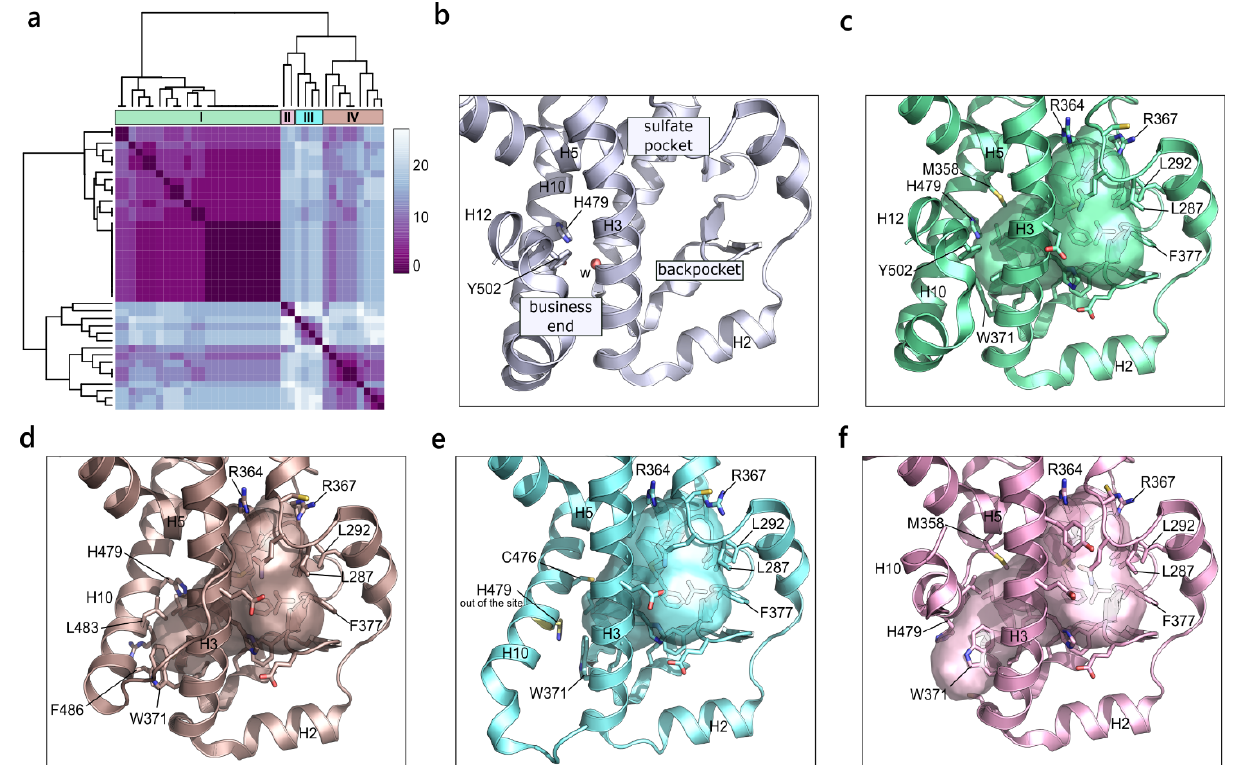
Figure 7. ( a ). ROR γ variability. Heatmap of the hierarchical clustering of ROR γ (PDB ID 5NI5). ( b ) Illustration of the ROR γ binding site. The main areas of the cavity are labelled. ( c ) Representation of the pocket described by cluster I as a result of the binding of agonist molecules or inverse agonist acting via the “water trap” mechanism (PDB ID 3KYT). ( d ) Pocket resulted from cluster IV and induced by inverse agonist acting via the “push and pull” mechanism (PDB ID 4WQP). ( e ) Representation of the pocket of cluster III. H479, pushed out of the binding site, is highlighted in yellow (PDB ID 5 × 8Q). ( f ) Depiction of the pocket described by cluster II (PDB ID 6Q2W).